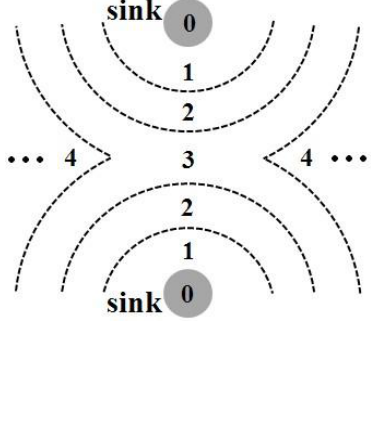
Figure 4. Two-sink case. Each number denotes a corresponding